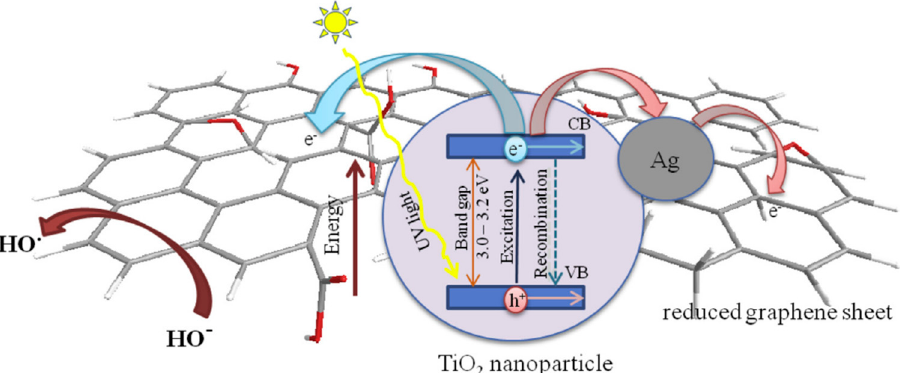
Figure 3. The photocatalytic mechanism of graphene/TiO 2 –Ag nanocomposites [44]. Reproduced with the permission of Mater. Chem. Phys .